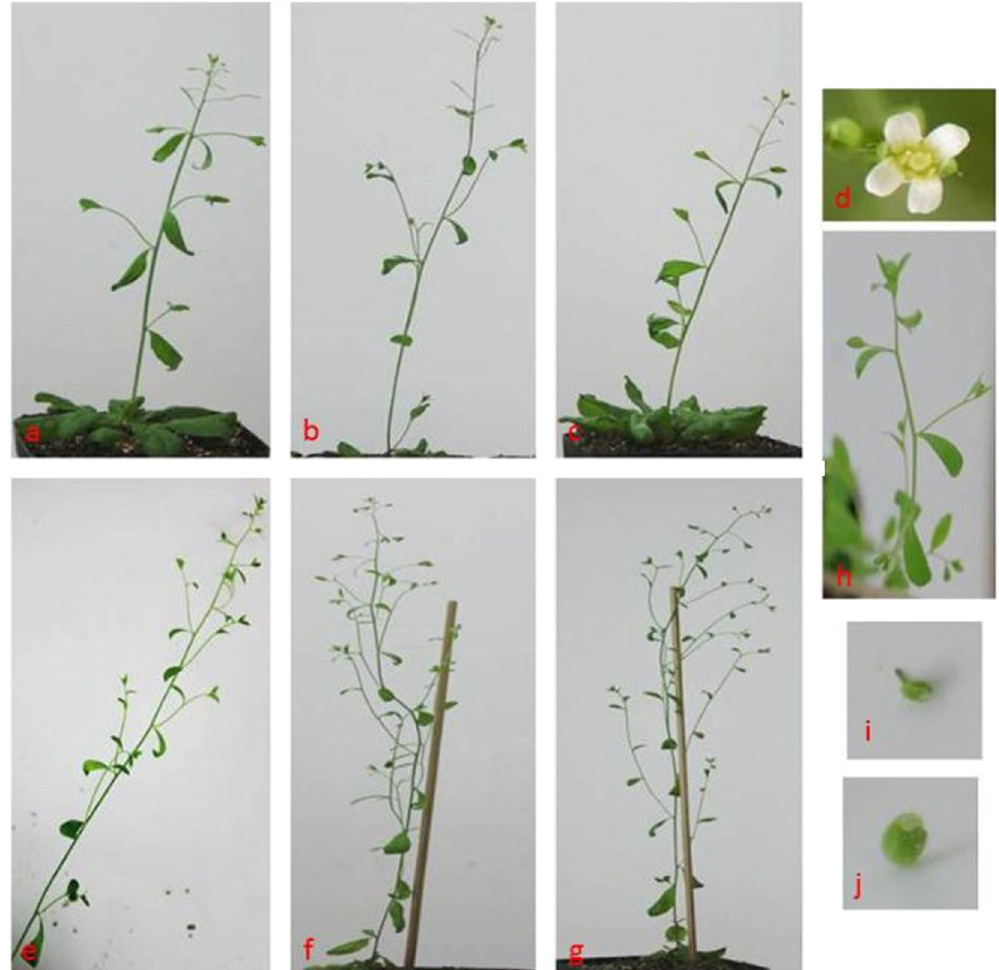
Figure 7. Phenotypic characters in Arabidopsis of constitutive IsLFY1 and IsLFY2 expressions. Figures from a to d are related to transgenes that the genes were crossed into wild Arabidopsis plants. Four-week IsLFY1 transgenic line ( a ), wild Arabidopsis plants ( b ), and IsLFY2 transgenic line ( c ). The IsLFY1 and IsLFY2 transgenic plants did not differ significantly in appearance from the wild-type plant. Flowers for the transgenic plants were consistent with the wild plants ( d ). Figures from e to j are related to transgenes that the genes were crossed into lfy-1 mutants. lfy-1 mutant ( e ). IsLFY1 transgenic line ( f ). IsLFY2 transgenic line ( g ). The IsLFY1 and IsLFY2 were inactive to rescue the lfy mutants. The transgenic plants and lfy mutant consistently showed that the early flowers were replaced by bracts, which subtended secondary inflorescences ( h ). The later flowers consisted of sepals and carpels ( i and j